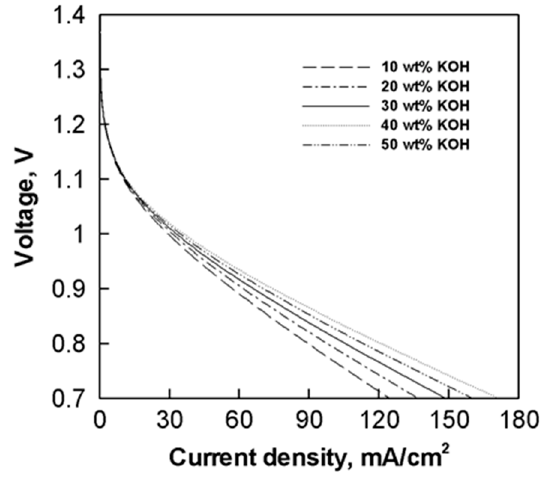
Figure 9. Effect of KOH concentration on cell performance.